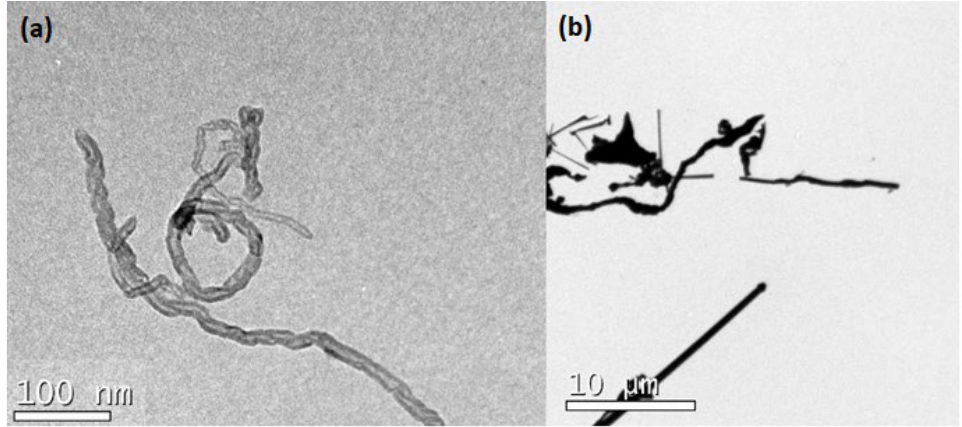
Figure 5. TEM image of: ( a ) CNT; and ( b )